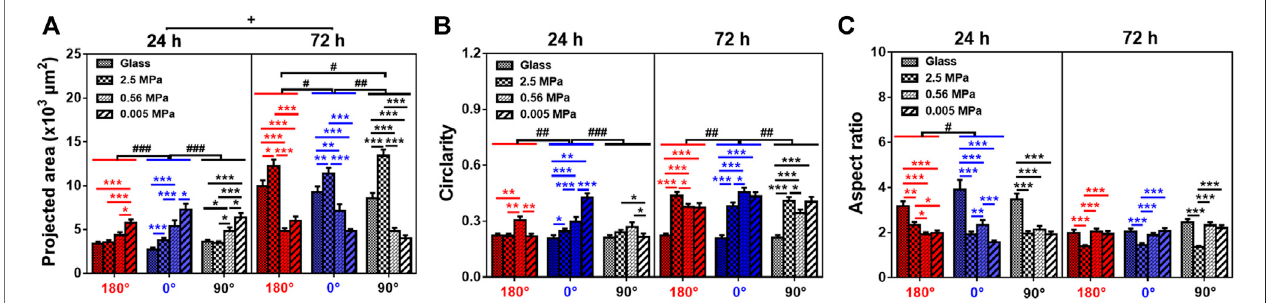
FIGURE6| Morphologicalchangeofratbonemarrow-derivedstemcells(rMSCs).Area (A) ,circularity (B) ,andaspectratio (C) ofrMSCsontoglassor2.5,0.56,or 0.005 MPapoly-dimethylsiloxaneinthreeorientations.Datawerecollectedfromthoseimagesforcellcontour(cf. SupplementaryFigureS5 )andpresentedasmean± SE of ~45 cells from three repeated experiments at 24 or 72 h. *, **, or ***, t -test, p < 0.05, 0.01, or 0.001; # , ## , or ### , two-way ANOVA test for different groups with different time with cell orientation, p < 0.05, 0.01, or 0.001; + , three-way ANOVA test for differences among stiffness, orientation, and duration, p <